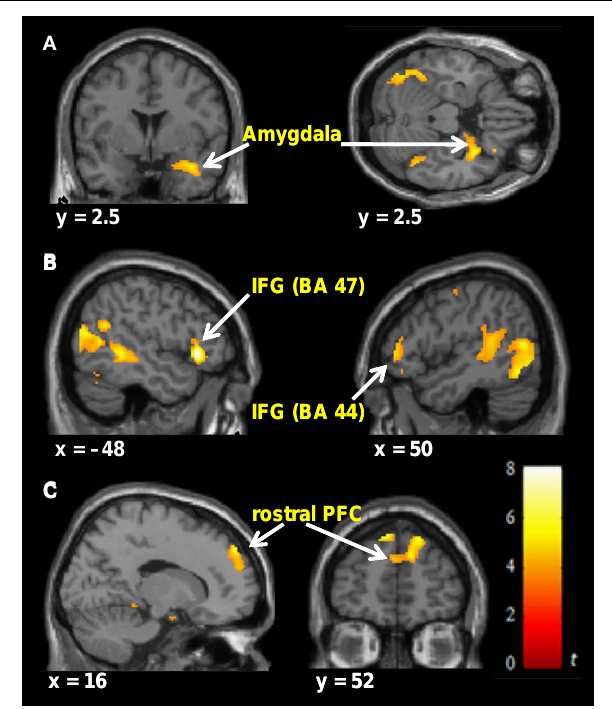
FIGURE 3 | Signifi cant hemodynamic activity during observation of avatar in pain compared with not in pain. Observing the avatar in pain compared with no pain evoked differences in brain activation in the right amygdala and periamygdala areas (A) , IFG (B) , and bilateral rostral PFC (rPFC) (C) . Images are superimposed on the coronal and sagittal sections of the single subject structural MNI